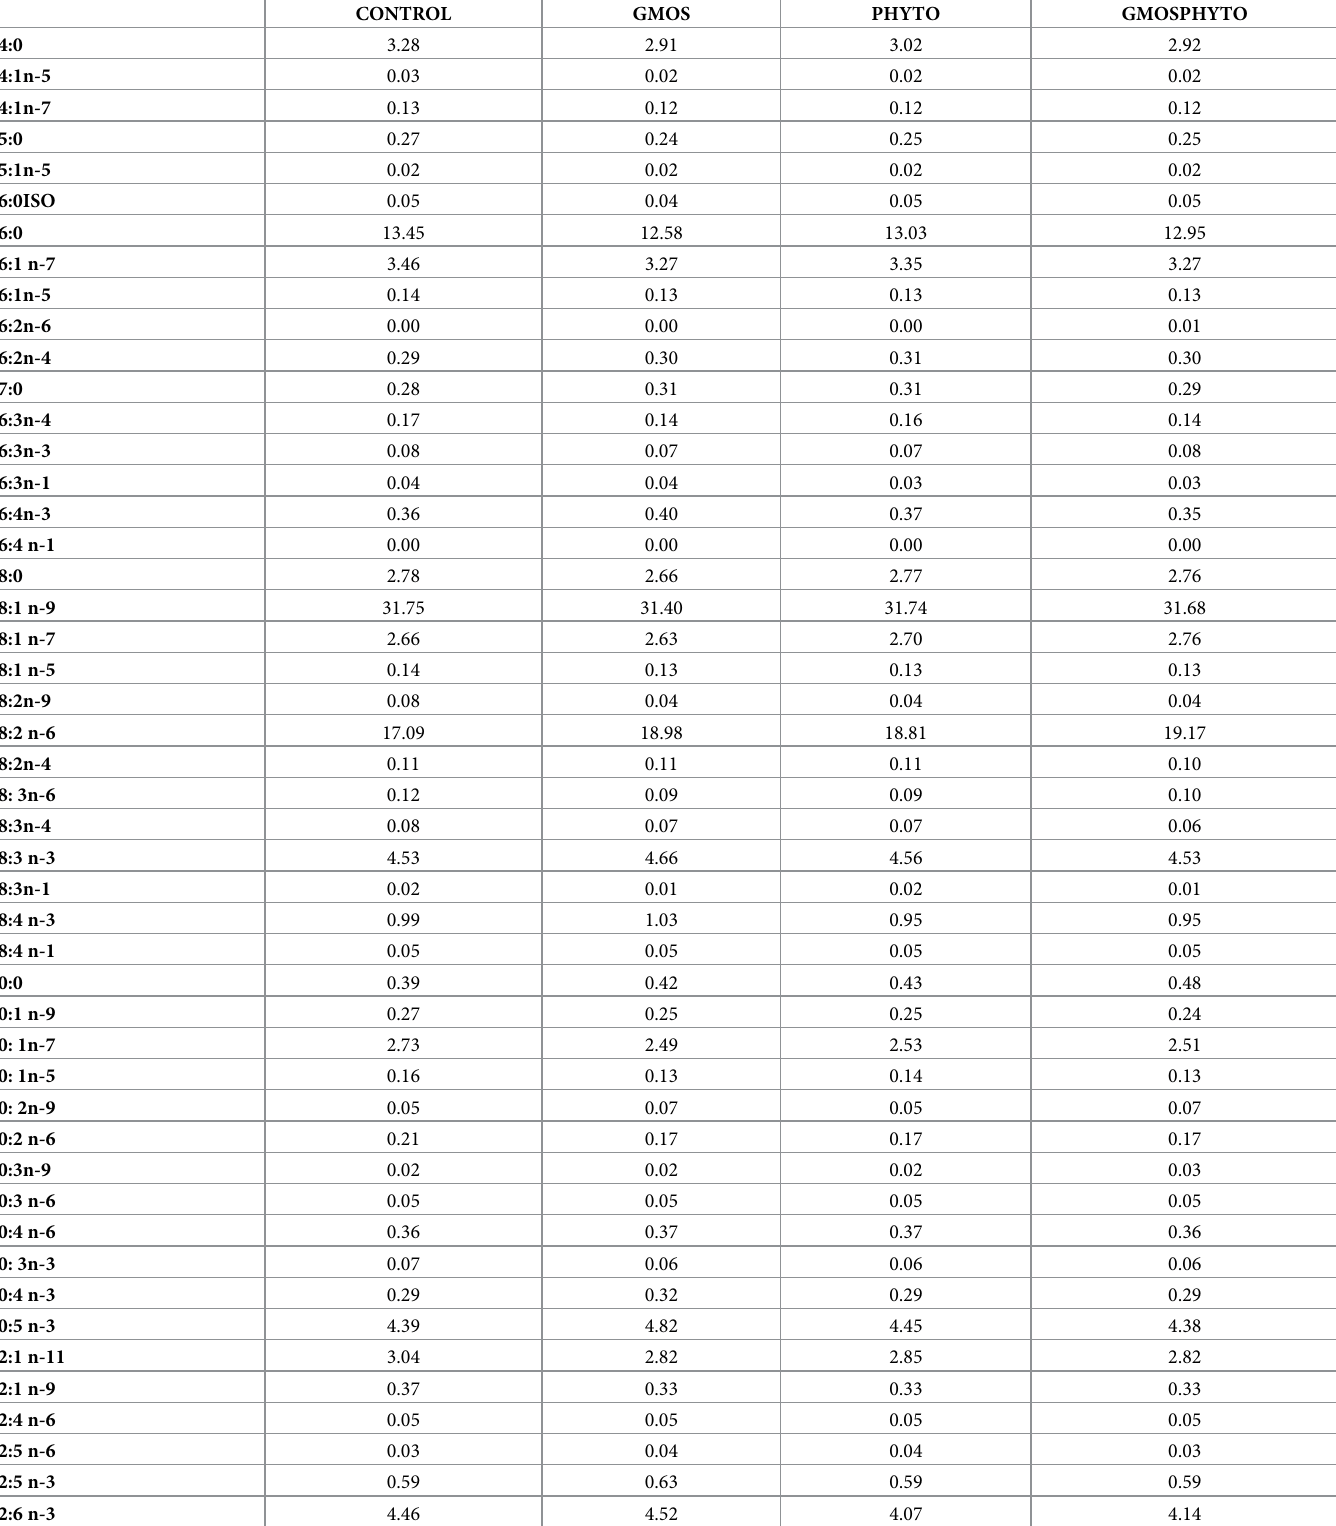
Table 2. Fatty acid composition (% of total identified fatty acids) of the experimental diets. CONTROL GMOS PHYTO GMOSPHYTO